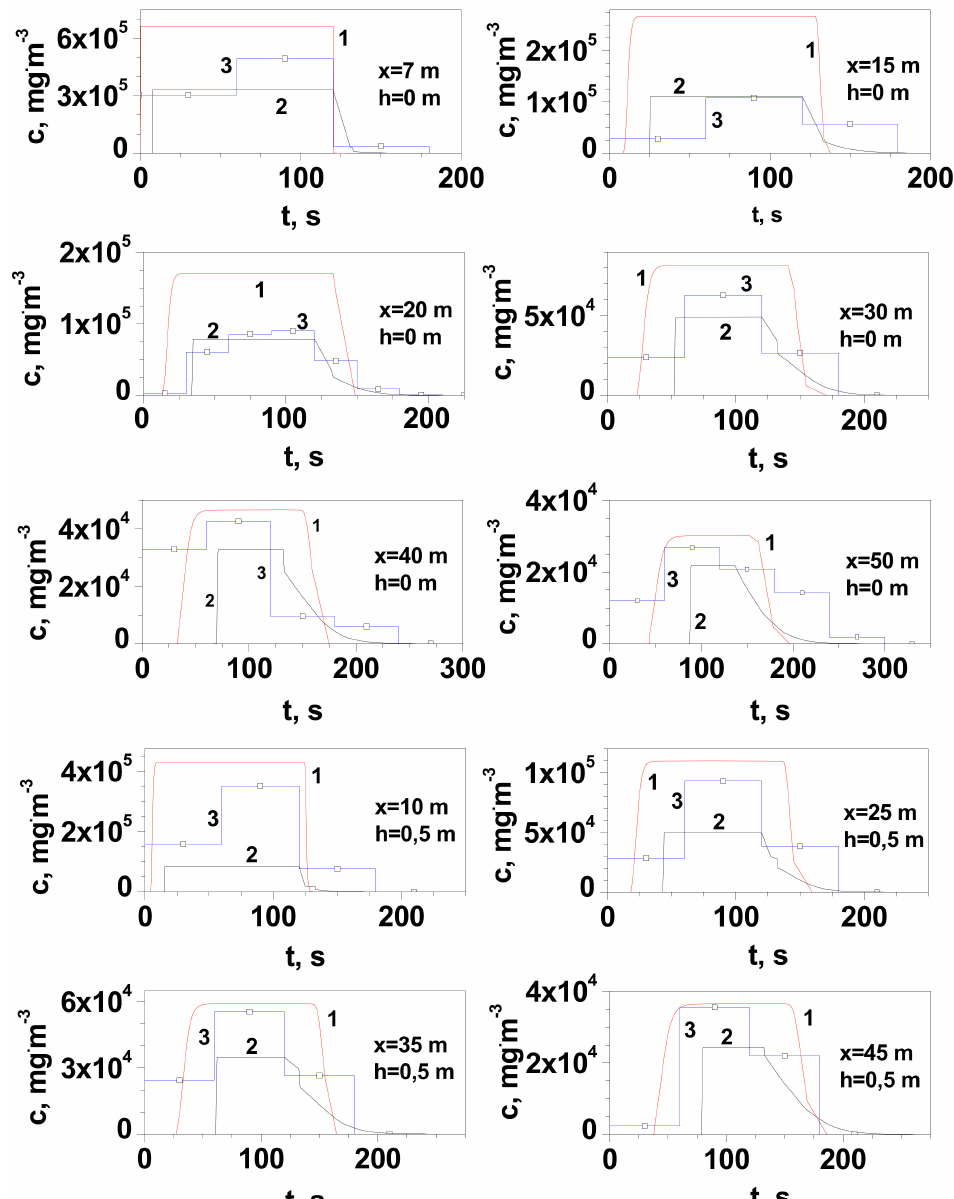
Figure 4. Comparison of the concentration dependence as a function of time for the Gaussian gas model ( 1 ) and the dense gas model ( 2 ) against the obtained experimental data ( 3 ) at height (h) and at distance (x) from the release location in the wind blowing direction. Atmospheric conditions of the measurement series 1: T = 19.2 ◦ C, v = 0.89 m/s, RH = 45%, p = 1003 hPa. Release parameters: Q = 1.67 kg/s, p out = 6 atm, t = 120 s, h = 0.75